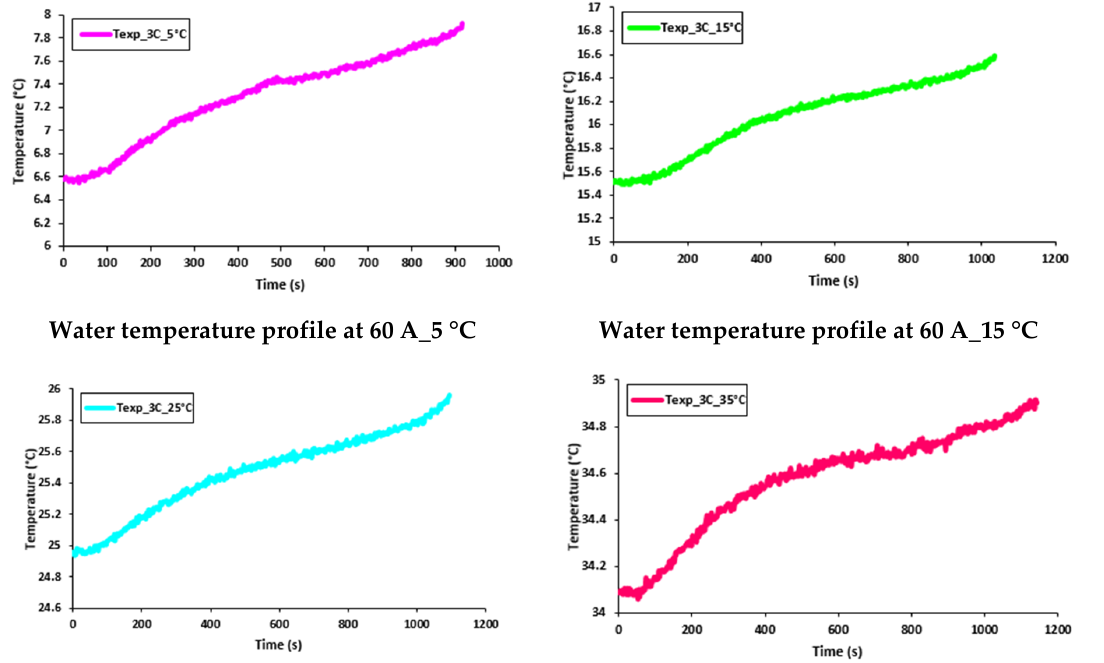
Figure 17. Transient temperature profile of water flow at 60 A with 5 °C, 15 °C, 25 °C, and 35 °C.